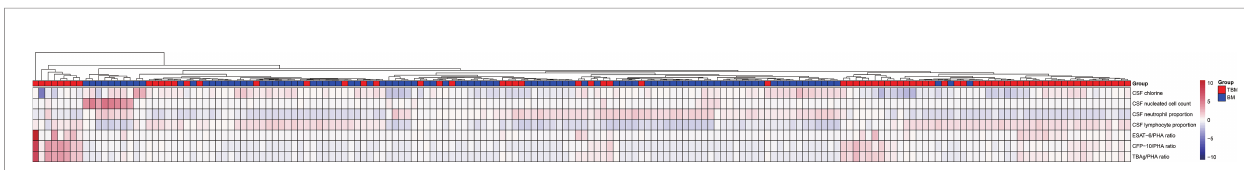
FIGURE 3 | The cluster analysis of various indicators in TBM group and BM group. Heatmap showing the cluster analysis of CSF chlorine, CSF nucleated cell count, CSF neutrophil proportion, CSF lymphocyte proportion, ESAT-6/PHA ratio, CFP-10/PHA ratio, and TBAg/PHA ratio in TBM patients (n = 76) and BM patients (n = 98). Each rectangle indicates a result of a patient. TBM, tuberculous meningitis; BM, bacterial meningitis; CSF, cerebrospinal fl uid; ESAT-6, early secreted antigenic target 6; CFP-10, culture fi ltrate protein 10; PHA, phytohemagglutinin; TBAg, tuberculosis-speci fi c antigen.